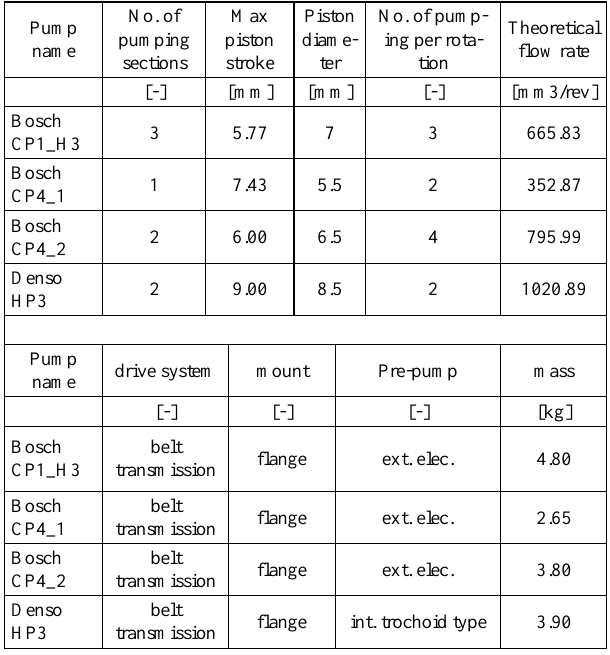
Table 3. Technical parameters of high-pressure pumps